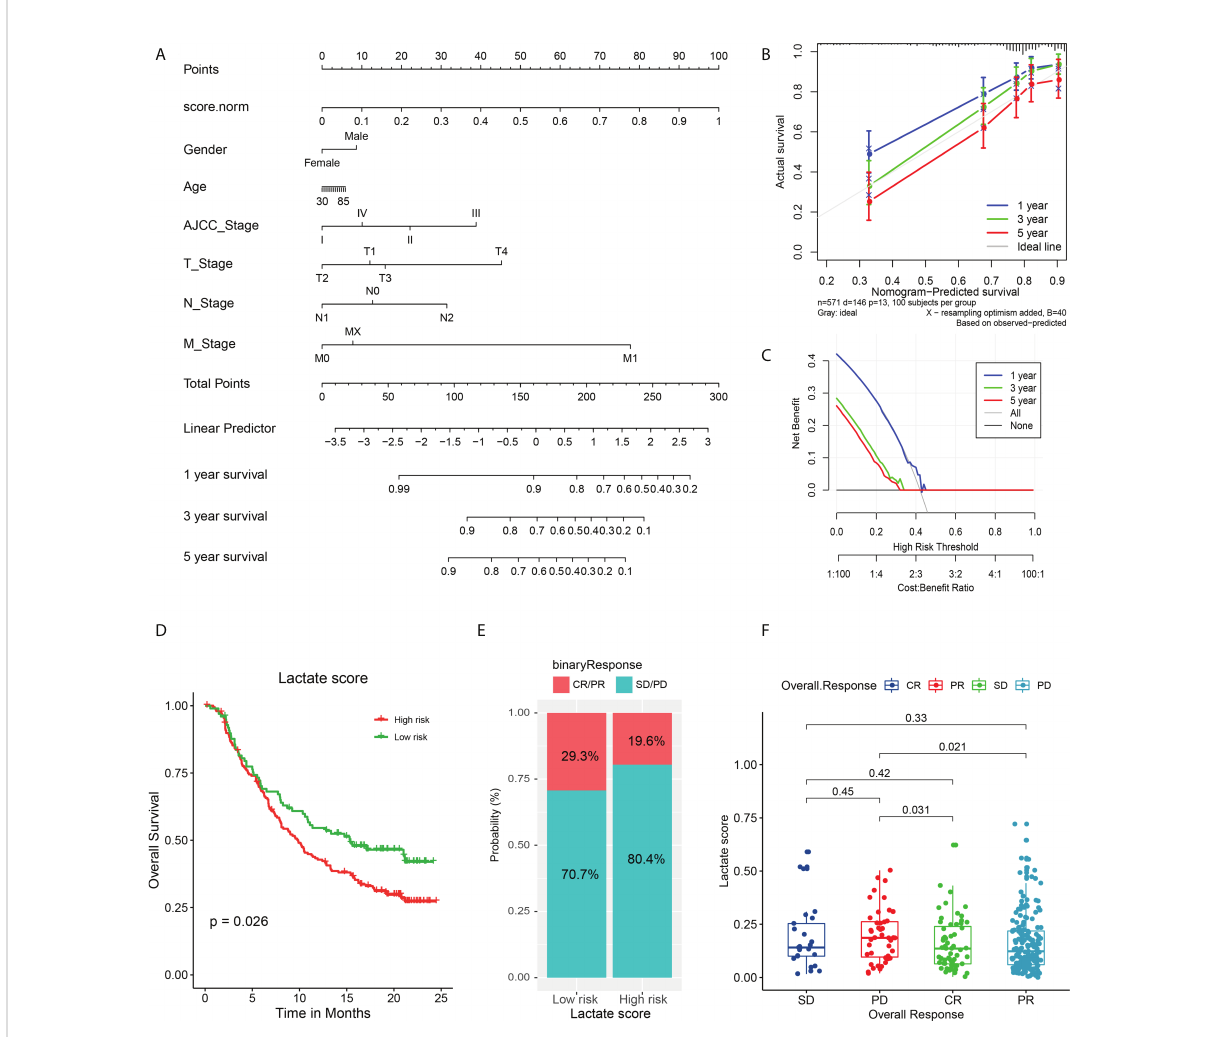
FIGURE 6 Validation of nomogram in predicting survival and application of lactate score in prognosis of immunotherapy. (A) A prognostic nomogram predicting 1-, 3-, and 5-year OS of TCGA COAD cohort. (B) The calibration curve of nomogram to predict 1-, 3-, and 5-year OS. (C) The decision curve analysis used to compare the ef fi ciency of nomogram to predict 1-, 3-, and 5-year OS. (D) The OS analysis of high and low risk groups in urothelial carcinoma cohort treated with PDL-1 inhibitor atezolizumab; P value has been derived from a log-rank test. (E) The response of immunotherapy in groups with high or low lactate score. The response status includes PR, CR, stable disease (SD), and PD. high lactate score patients: CR/PR (29/99); SD/PD (70/99), low lactate score patients: CR/PR (39/199); SD/PD (160/199) (F) Comparison of lactate score among different response statuses; P value has been derived from Wilcoxon rank sum